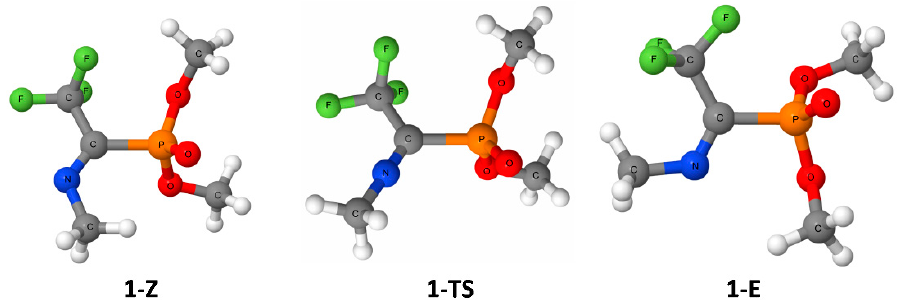
Figure 3. Optimized structures of the Z- and E-isomers ( 1-Z and 1-E , respectively), and the transition state of the isomerization reaction 1-Z → 1-E ( 1-TS ). Hereinafter, the structures are presented using the Jmol program [26,27,41].